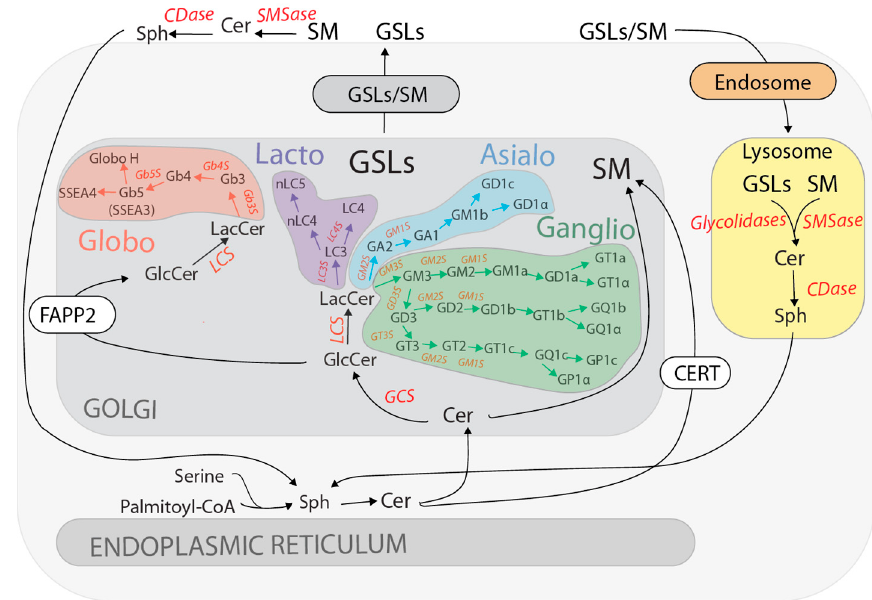
Figure 1. GSL synthesis and turnover. Schematic representation of the metabolism of the major GSL classes synthesized along the secretory and endocytic pathways. For details refer to the text. GSEs catalysing the major synthetic reactions and the enzymes involved in GSLs/SM dismantling are reported in red. GSLs, glycosphingolipids; Sph, sphinganine from the de novo pathway or sphingosine from the salvage pathway; Cer, ceramide; SM, sphingomyelin; GCS, GlcCer synthase; LCS, LacCer synthase; CERT, ceramide transfer protein; FAPP2, four-phosphate adaptor protein 2; SMSase, sphingomyelinase; CDase, ceramidase.